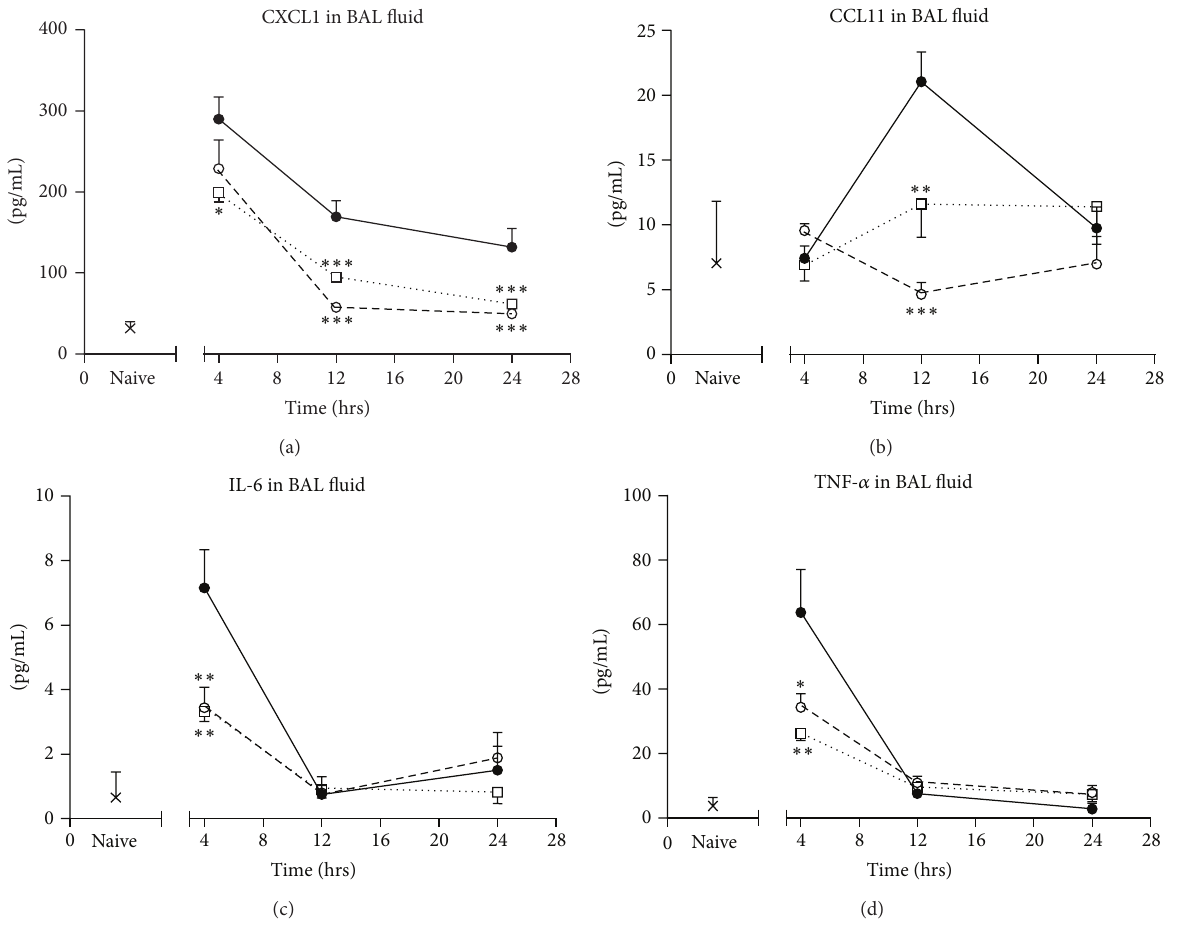
Figure 3: Effects of drug treatment on production of proinflammatory cytokines (a) CXCL1, (b) CCL11, (c) IL-6, and (d) TNF- 𝛼 in BAL fluid. Animals were treated with vehicle (— e —), ISU201 (-- ◻ --), or dexamethasone ( ⋅⋅⋅ I ⋅ ⋅ ⋅ ) at 2 and 8 hours after induction of an exacerbation. Data are mean ± SEM ( 𝑛 = 6 animals per group). Significant differences relative to vehicle-treated animals at each time point are shown as ( ∗ 𝑃 < 0.05 ), ( ∗∗ 𝑃 < 0.01 ), and ( ∗∗∗ 𝑃 < 0.001